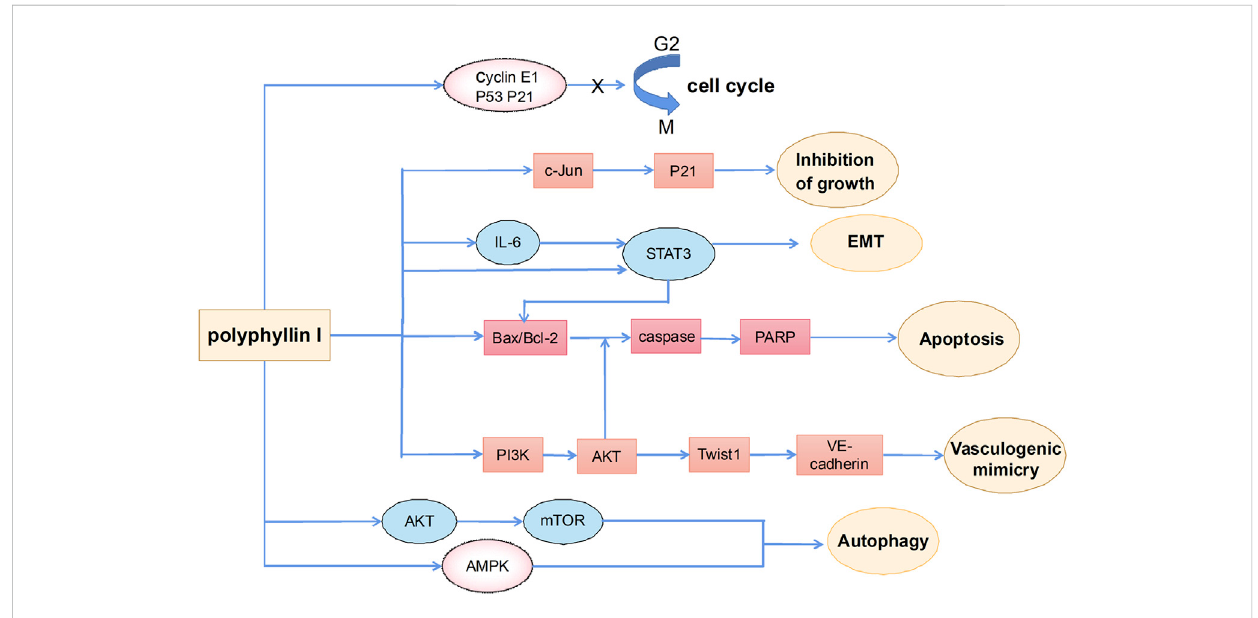
The primary mechanism for the anti-tumor effects of Polyphyllin